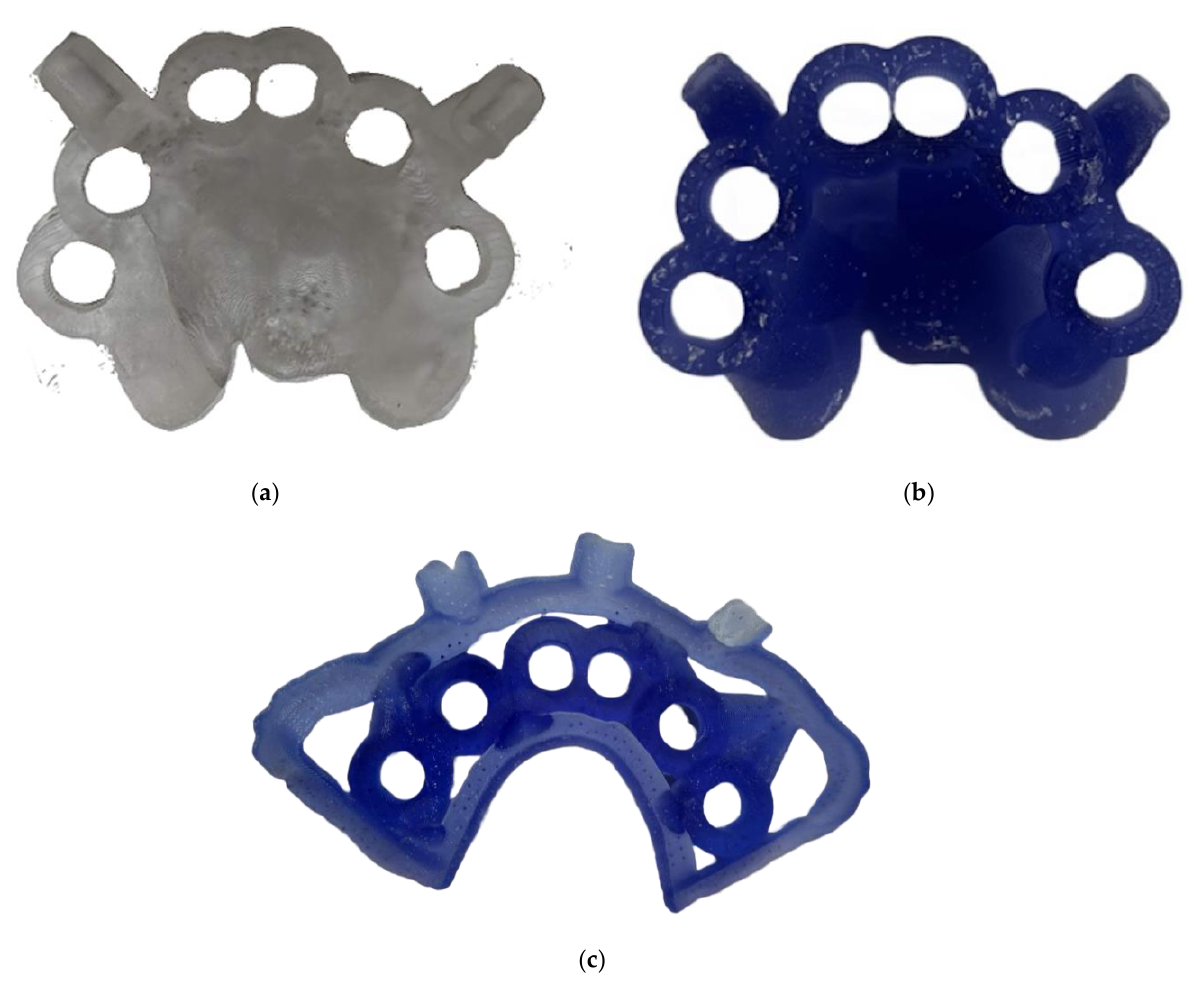
Figure 6. Upper implant surgical guides in both resins: ( a ) DentaClear; ( b ) DentaGuide. ( c ) Lower surgical guide in DentaGuide resin.